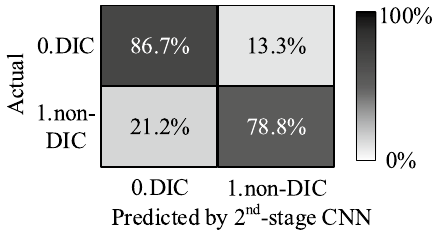
Figure 10. Identification accuracy of the second-stage CNN model.